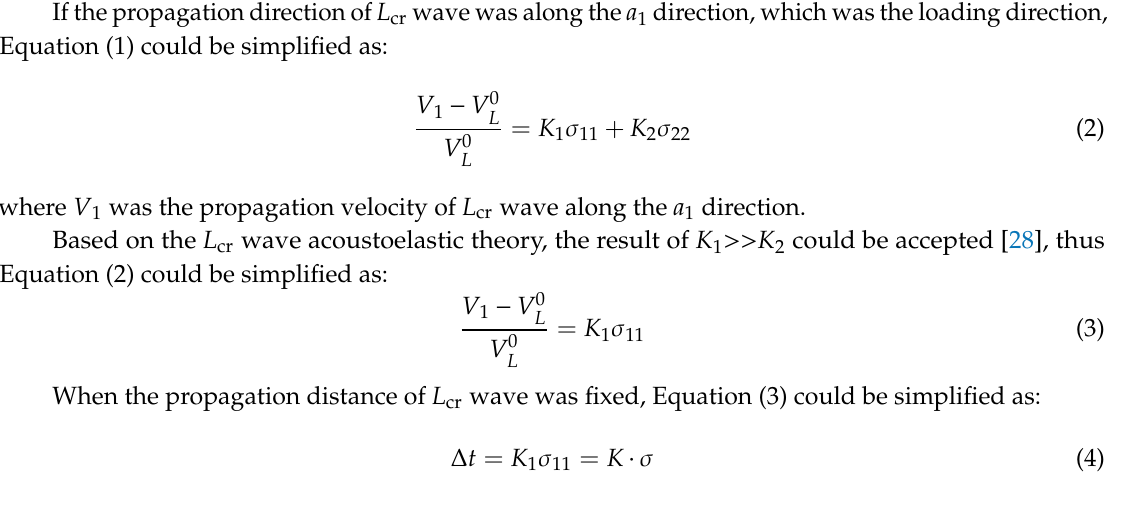
Figure 2. The three-dimensional plane in the orthogonal rectangular coordinate axis.